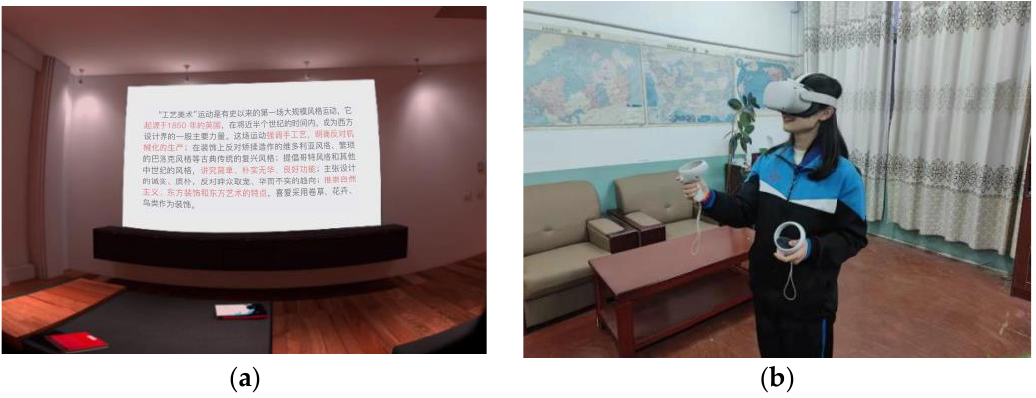
Figure 5. Scene in virtual reality ( a ) and participant' experimental procedure ( b ).